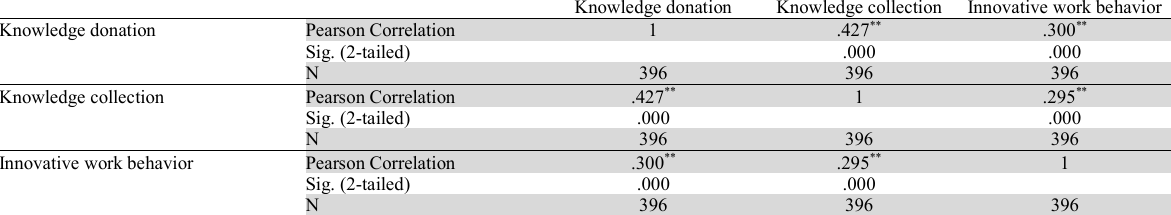
Results of correlation analysis